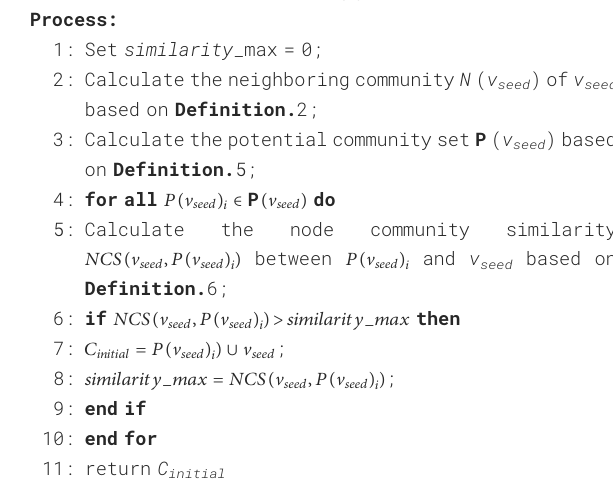
Algorithm 3. Community initialization.